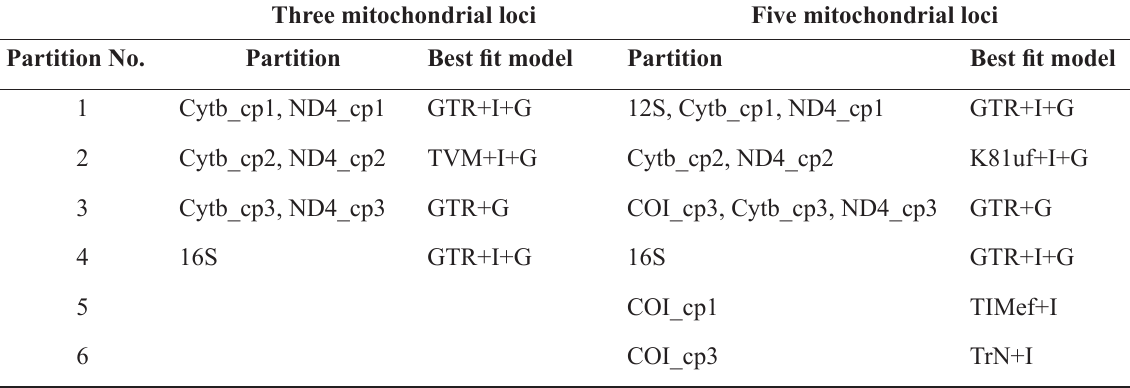
Table 3. Partition schemes and best-fit substitution models are selected in PartitionFinder. A total four partitions for three mitochondrial loci and six partitions for five mitochondrial loci with their best fit models are predicted by PartitionFinder. Cp1–cp3 indicates the codon positions of each locus. Three mitochondrial loci Five mitochondrial loci Partition